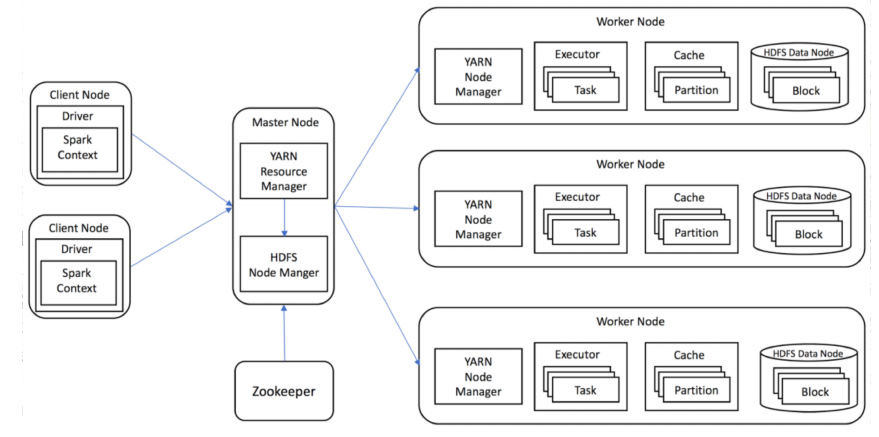
Figure 2. The architecture of